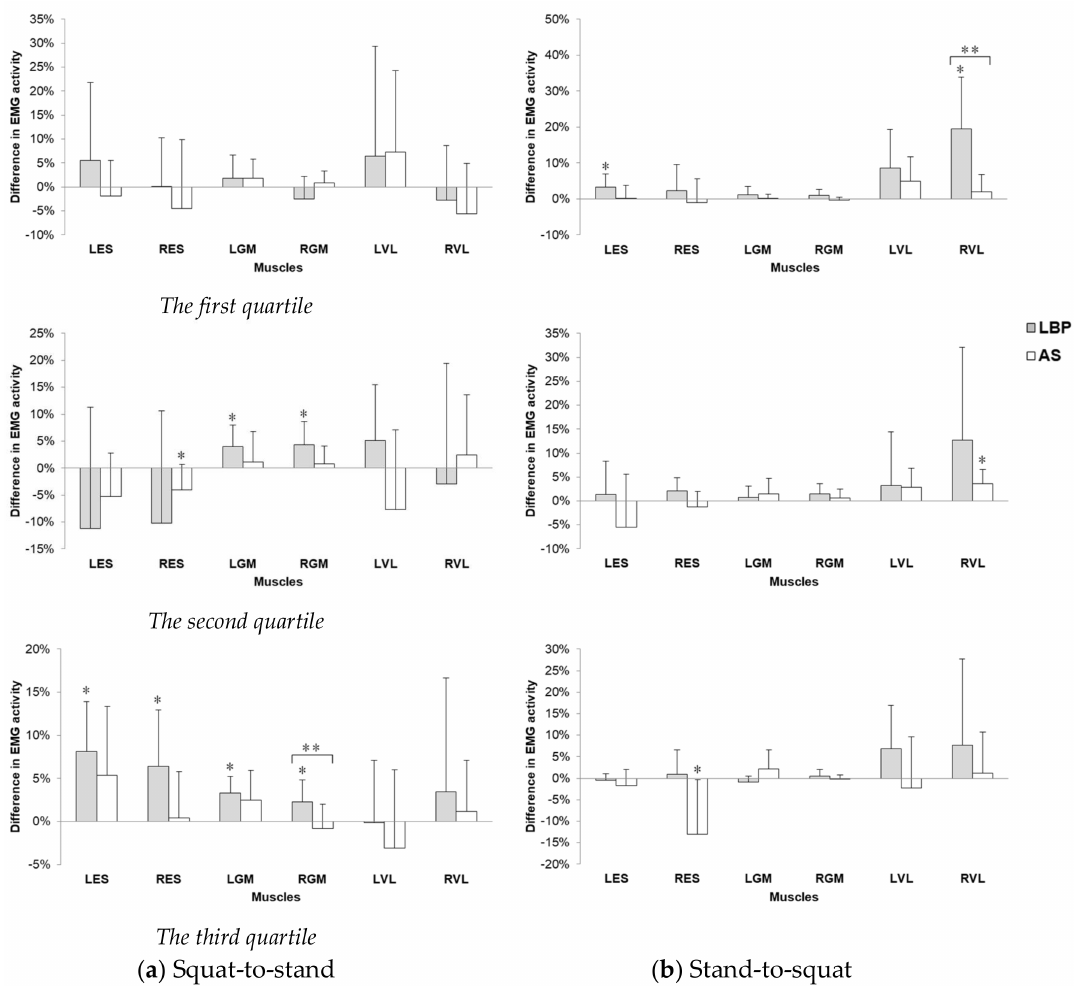
Figure 6. Changes in EMG activity of muscles (mean ± 1SD) before and immediately after 15 min deep squatting at the three quartiles during ( a ) squat-to-stand phase and ( b ) stand-to-squat phase. L = left, R = right, ES = erector spinae muscle, GM = gluteus maximus muscle, VL = vastus lateralis muscle. Positive values of the changes indicate an increase in muscle activity (expressed in %MVC) at post-assessment compared to pre-assessment. * Indicates significant within-group differences and ** indicates significant time × group